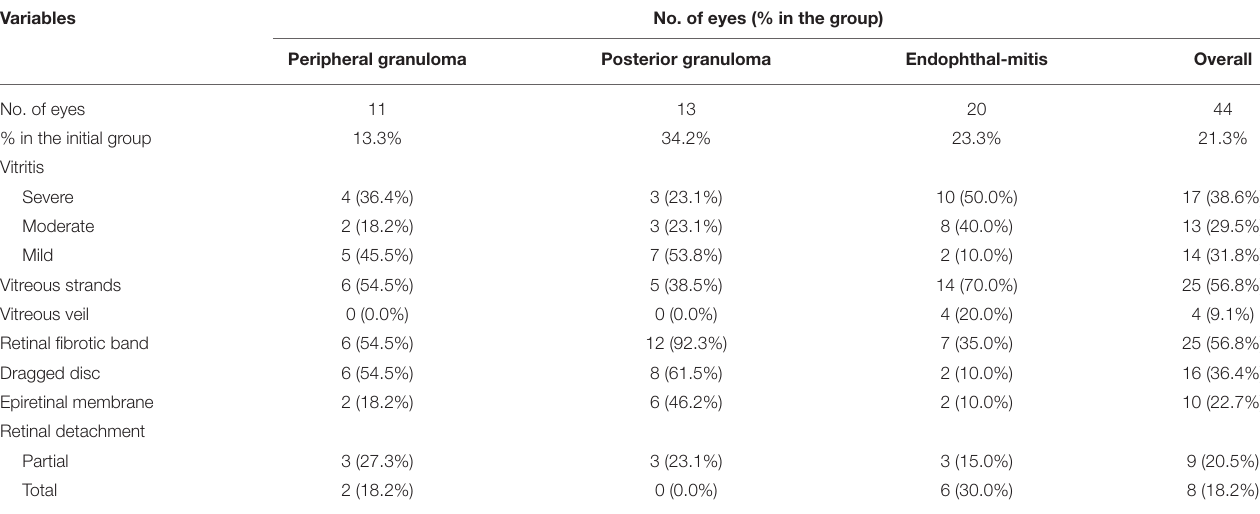
TABLE 4 | Major clinical features of the serum and aqueous T-IgG negative